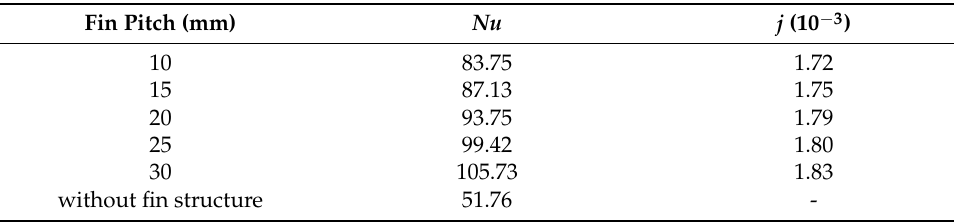
Table 3. Nusselt number and Colburn factor under different fin pitch p.